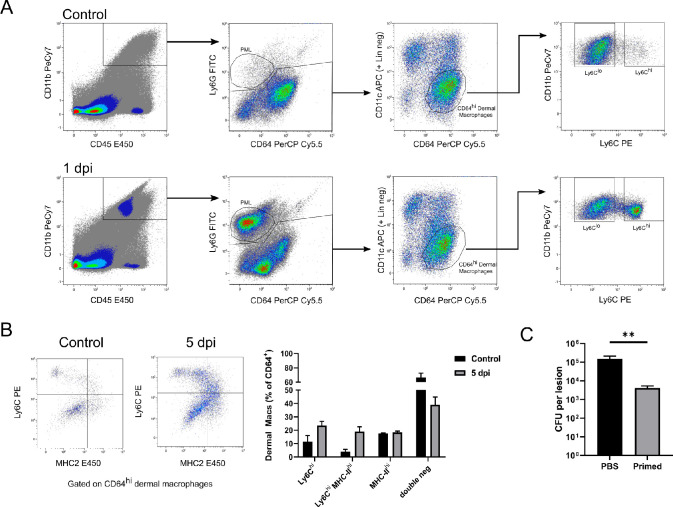
Gating Strategy used to distinguish dermal macrophages.(A) Representative FACS plots showing gating strategy used to identify tissue resident dermal macrophages in uninfected and 1 day post infection (naïve) wt mice. Resident dermal macrophages are defined as CD45hi CD11bhi CD64hi CD3lo CD11clo. (B) Representative FACS plots showing gating strategy used to distinguish Ly6C expression of dermal Mφ within the CD64hi population. (C) Bacterial load of wt mice injected with PBS or S. aureus and (re-)infected for an additional 5 days (n:8 biological replicates representing two independent experiments). Data were analyzed using either two tailed Mann-Whitney test. Error bars represent mean ± SEM, **p<0.01.